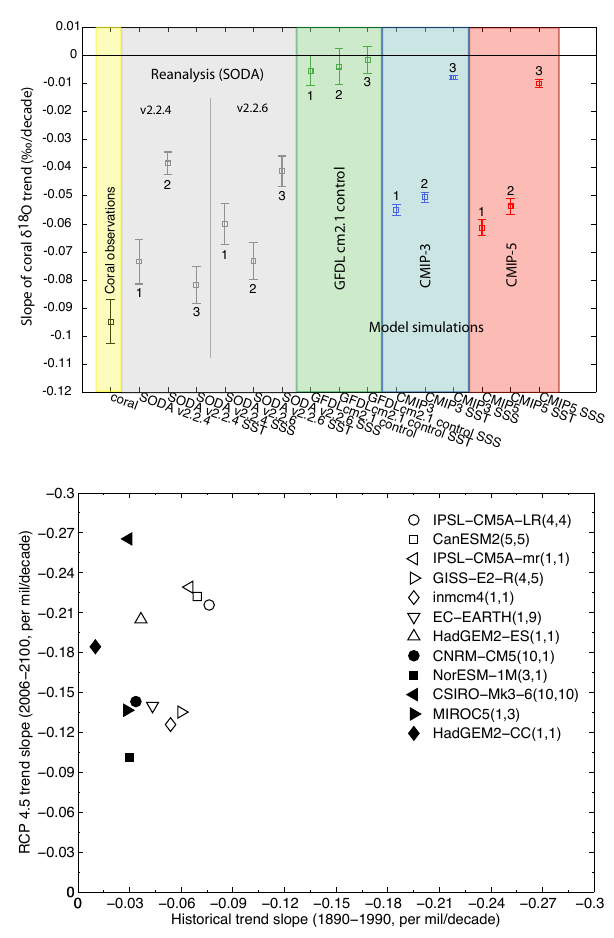
Fig. 10. Upper panel: magnitude of the trend in δ 18 O c (‰/decade, computed from a simple linear regression through the trend PC) in corals (far left), Simple Ocean Data Assimilation (SODA) 20th-century reanalysis (Carton and Giese, 2008; Giese and Ray, 2011; Compo et al., 2011), a 500yr control run from GFDL CM2.1 (Wittenberg, 2009), and the CMIP3 and CMIP5 multi- model ensembles. In each case, δ 18 O c was modelled from SST and SSS (1), SST only (2), and SSS (3). Lower Panel: magnitude of the δ 18 O c trend (‰/decade, computed from a simple linear regres- sion through the trend PC) over 1890–1990 in pseudocorals mod- elled from CMIP5 historical simulations and over 2006–2100 in the RCP 4.5 projections where numbers in parenthesis indicate the number of runs in the historical and RCP 4.5 ensemble,